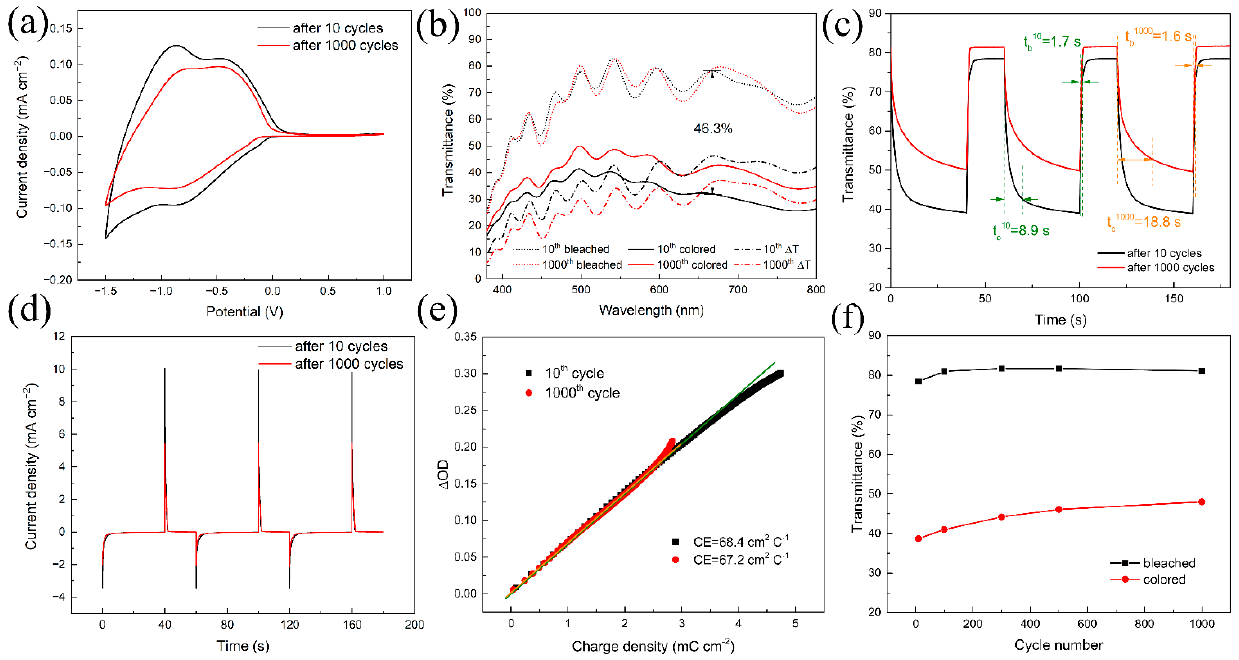
Figure 10. The electrochemical and EC performance of all-solid-state ECD. ( a ) CV curves of the all- solid-state ECD after 10 cycles and 1000 cycles; ( b ) Optical transmittance spectra of the colored state, bleached state and transmittance modulation Δ T; ( c ) In situ transmittance measurements at 550 nm performed at − 1.5 V for 40 s and 1 V for 20 s; ( d ) Current density–time curves corresponding to ( c ); ( e ) Optical density vs. charge density of the ECD at 550 nm; and ( f ) Cyclic stability of the ECD. Figure 10b exhibits the transmittance spectra of the ECD in the bleached state (T b )